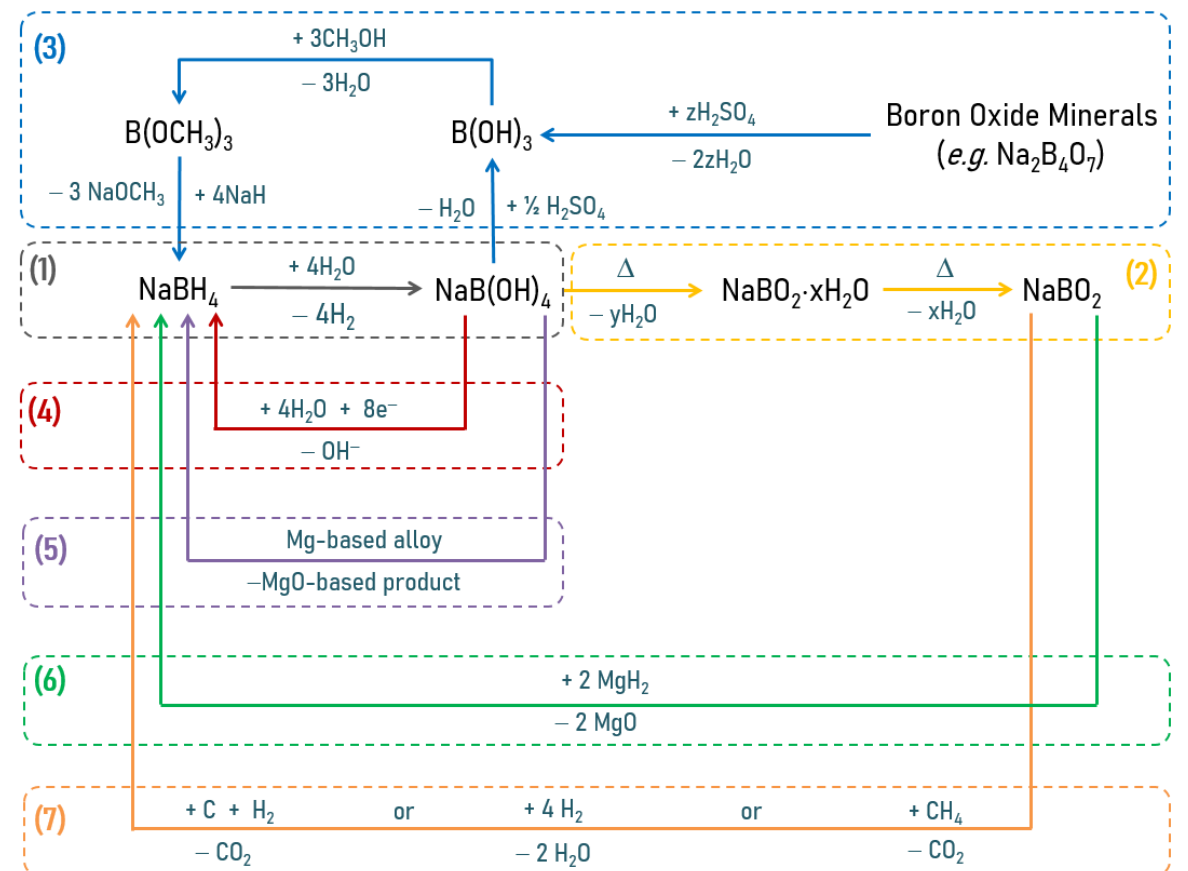
Figure 2. Hydrogen cycle with sodium borohydride: (1) hydrolysis of NaBH 4 ; (2) dehydration of the hydrated borate product NaB(OH) 4 ; (3) Brown–Schlesinger process used for the commercial production of NaBH 4 ; (4) electroreduction of NaB(OH) 4 for regenerating NaBH 4 ; (5) chemical reduction of NaB(OH) 4 by means of a Mg-based alloy; (6) chemical reduction of NaBO 2 using magnesium hydride; (7) chemical reduction of NaBO 2 using various reducing agents.